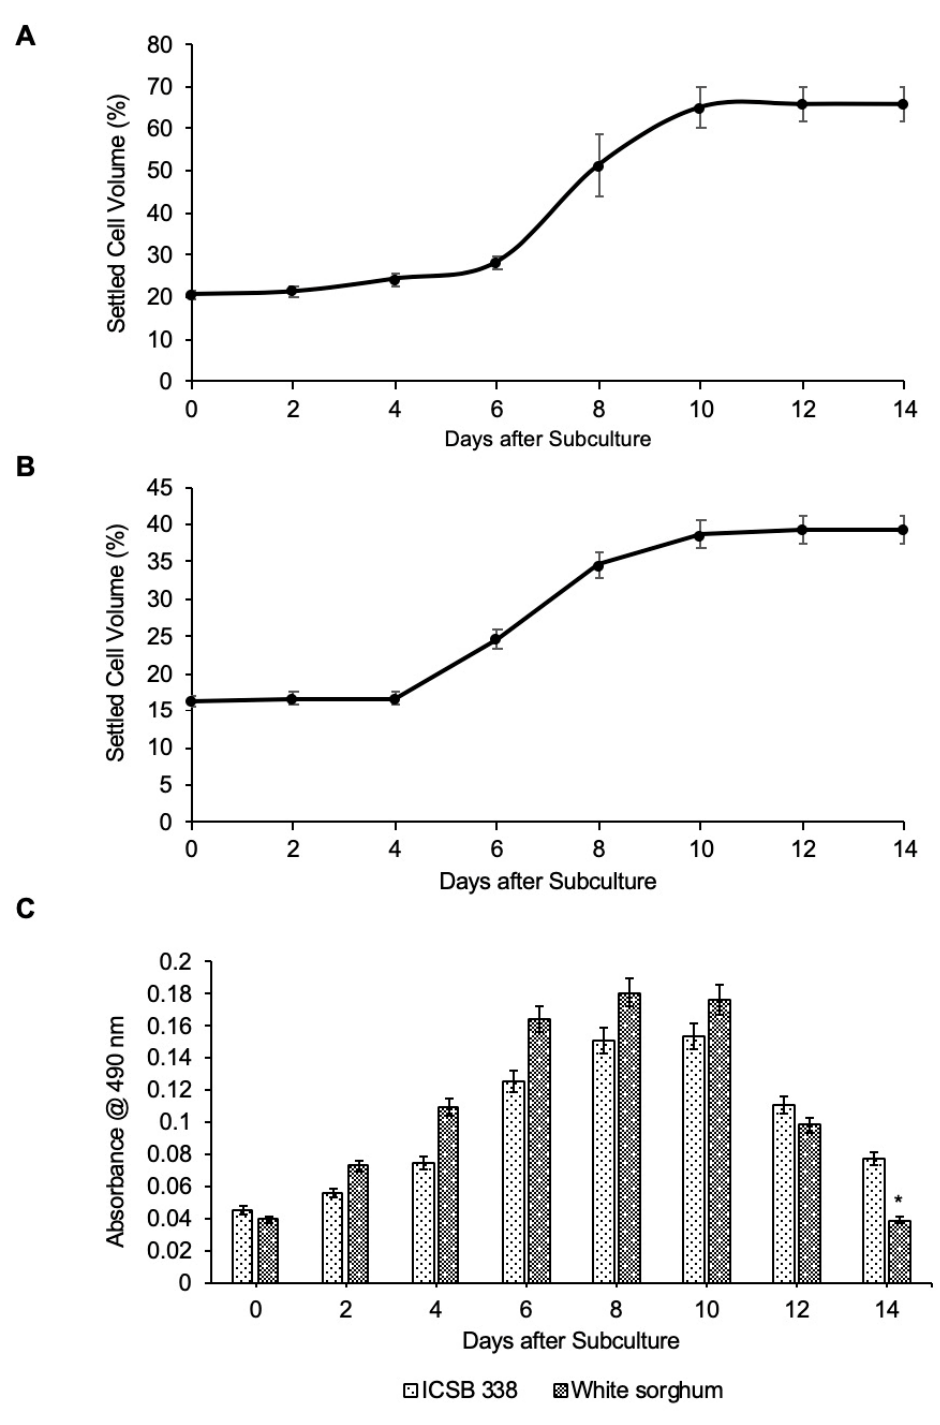
Figure 4. The growth curves and cell viability assays of sorghum cell suspension cultures. ( A ) Growth curve of ICSB 338. ( B ) Growth curve of White sorghum. The growth curve readings were done for three independent biological replicates for each seed type using the settled cell volume (SCV) method. ( C ) Cell viability readings of ICSB 338 and White sorghum cell cultures using the MTT assay. The cell viability readings at each time point is an average of two technical replicates from three independently established cell suspension cultures. Data presented as mean ± se ( n = 3). * indicates statistically significance at a 5% level of significance according to Wilcoxon rank-sum test ( p < 0.05).